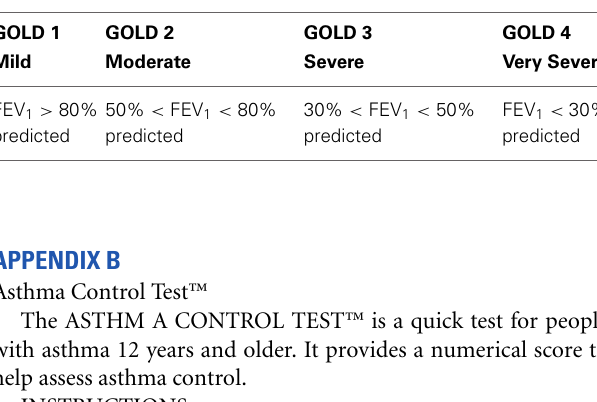
Table A2 | Classification of severity of airflow limitation in COPD (based on post-Bronchodilator FEV 1